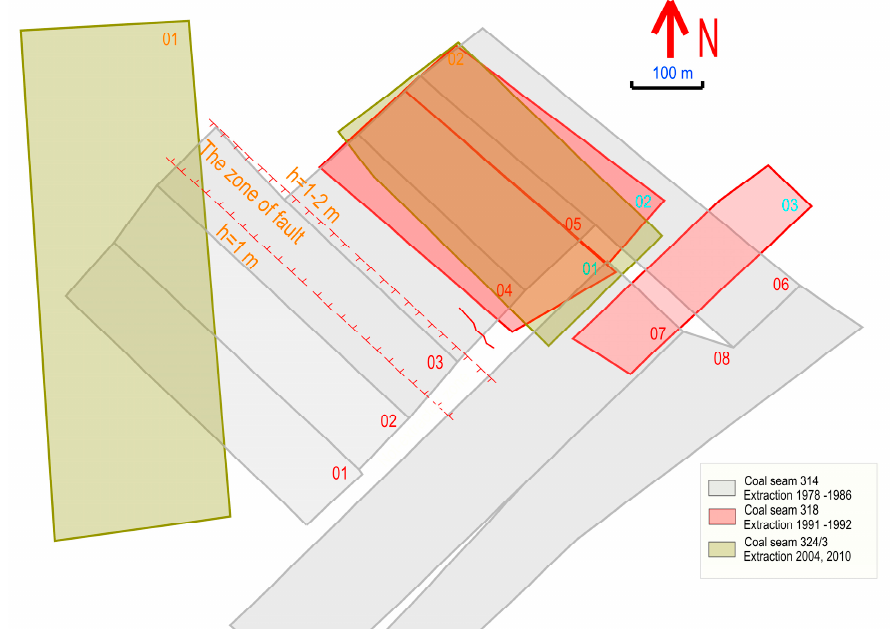
Figure 9. Location of the mining exploitation in relation to the deformation.